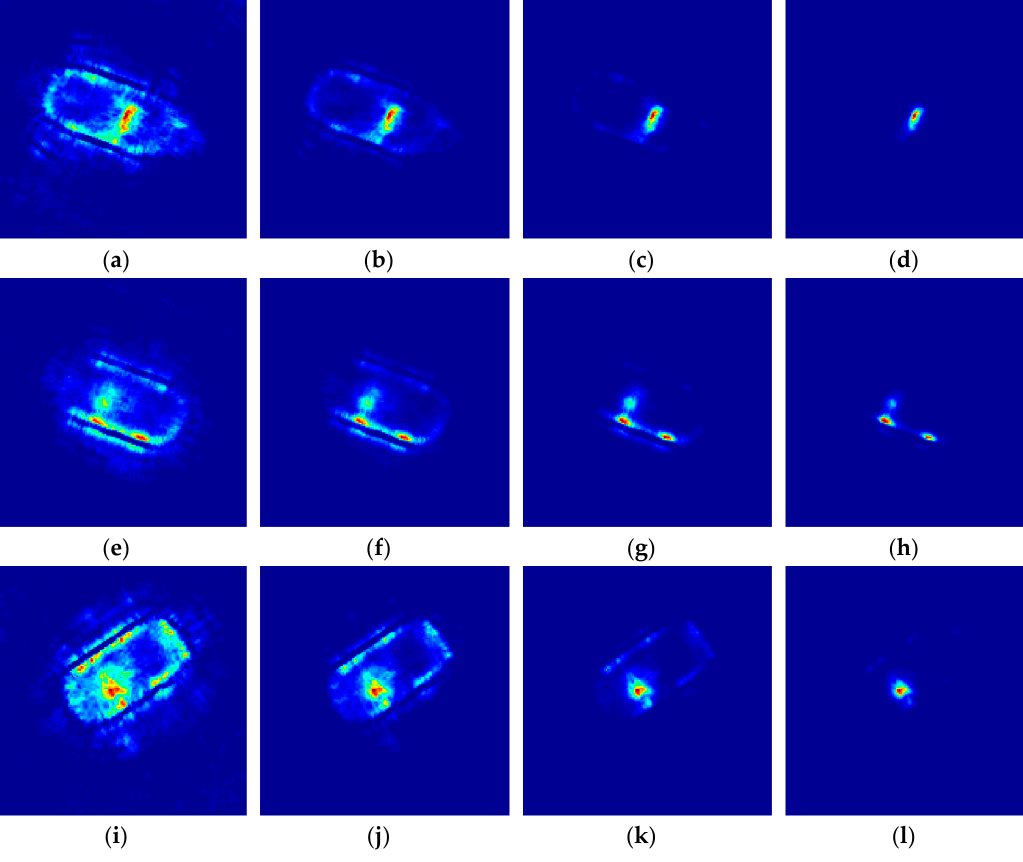
Figure 5. Examples of the speckle reduction effect of three vehicle models in different iteration times: